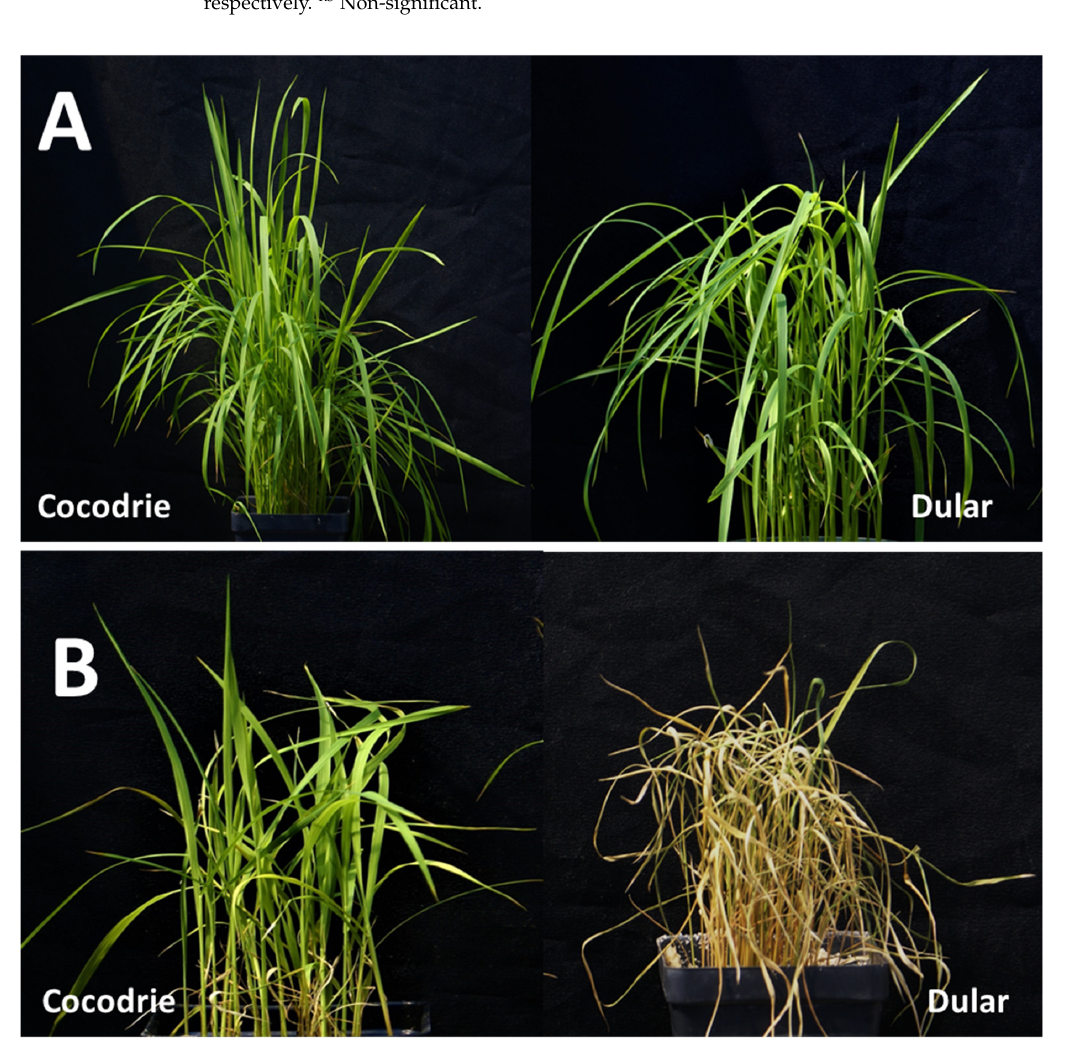
Figure 2. Performance of Cocodrie and Dular under control ( A ) and alkaline stress environments ( B ).